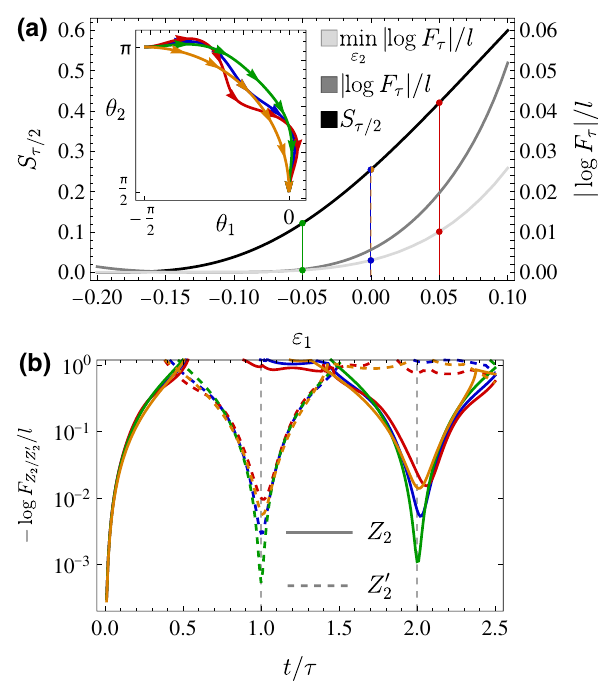
FIG. 4. (a) The dependence of entanglement entropy at t = τ/ 2 and fidelity at t = τ with respect to a single trajec- tory deformation parameter ε 1 at ε 2 = 0. The inset shows example optimized trajectories at ε 1 = − 0.05, 0, 0.05 and ε 2 = − 0.02, − 0.05, − 0.08 (green, blue, and red, respectively); the increase in fidelity is related to these trajectories avoiding the high-leakage areas depicted in Fig. 3. We observe that at ε = − 0.05 we can obtain relatively high fidelity when driving the state from a product state to an entangled one at t = τ/ 2 and back. In panel (b) we show the overlaps with the Z 2 / Z (cid:6) these trajectories [color coded as in panel (a)] as well as the scar trajectory